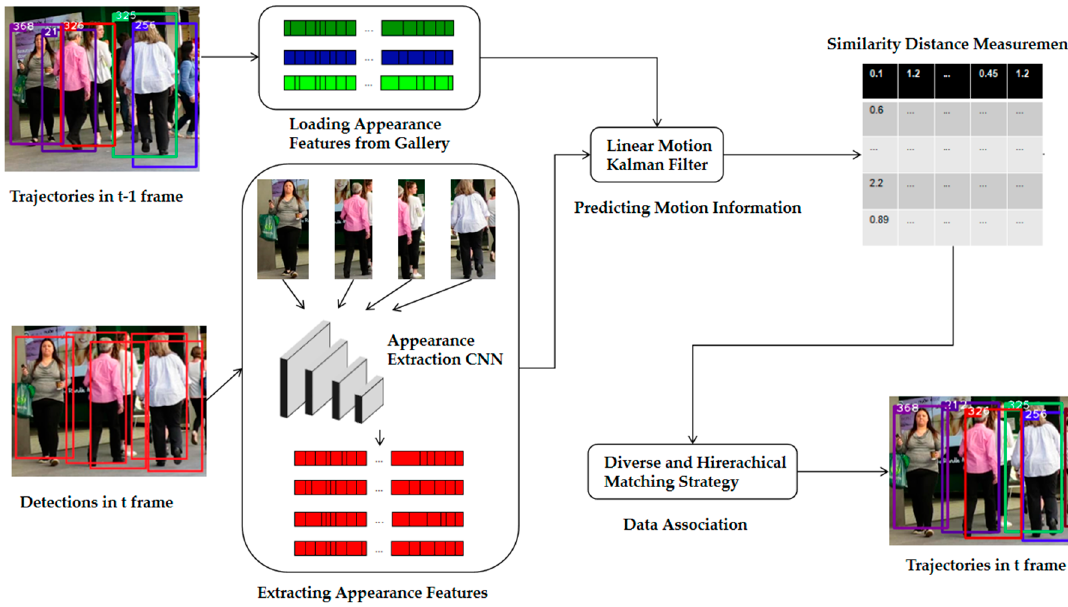
Figure 1. Proposed multi-object tracking pipeline is illustrated. At the beginning, we load the appearance features of trajectories in the t–1 frame from gallery, and extract the appearance features of detections in the t frame. Then, we predict motion information of the above trajectories and detections by using a Kalman filter. We measure their similarity distance through our proposed equation after obtaining the appearance and motion information. In the end, we match the trajectories and detections with the designed matching strategy.